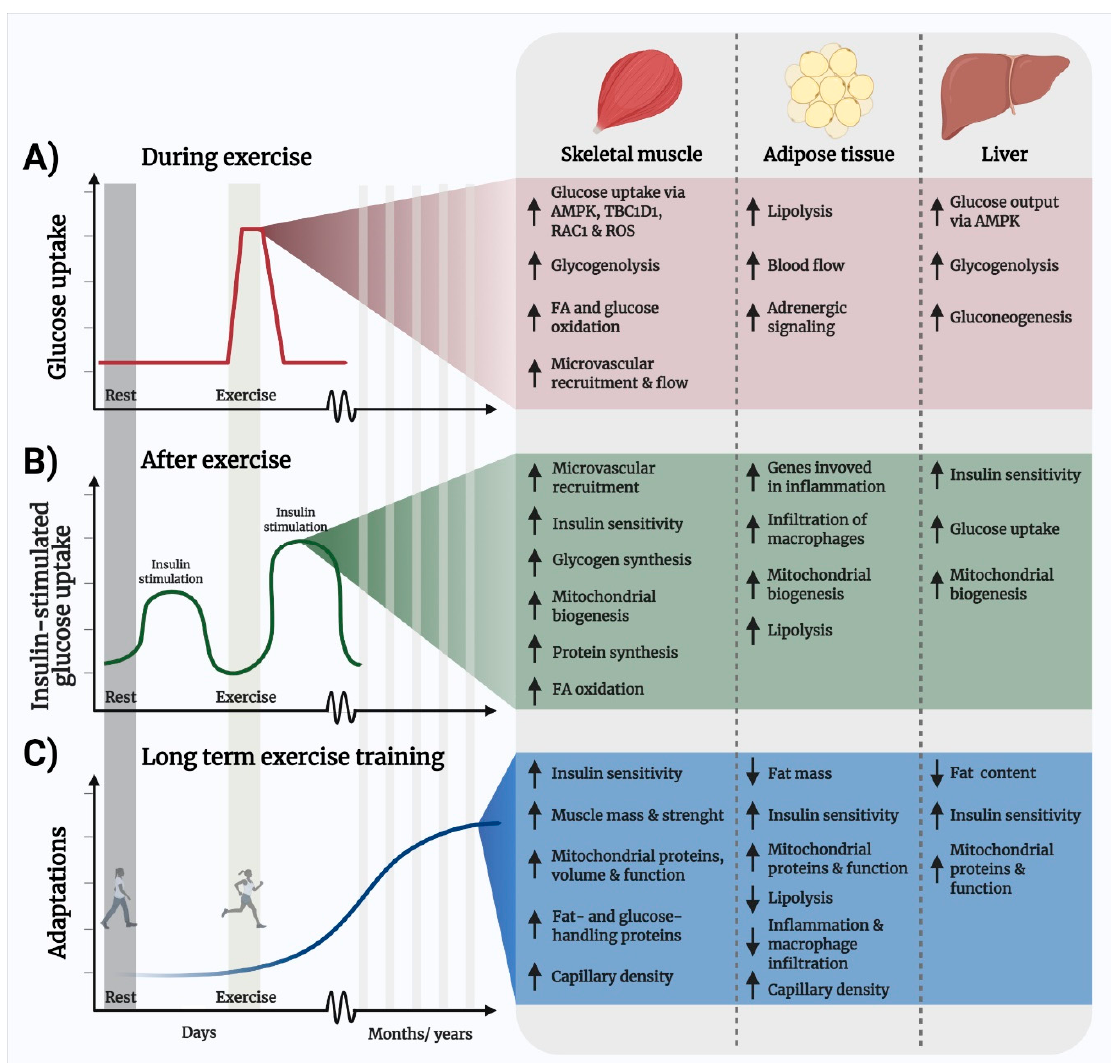
Figure 3. Illustration of the temporal metabolic benefits of exercise and molecular mechanisms . ( A ) One exercise bout elicits an acute and transient increase in muscle glucose uptake that is independent of insulin and persists in insulin-resistant subjects. ( B ) Insulin sensitivity (illustrated here as insulin-stimulated glucose uptake) is transiently enhanced for up to 48 h after the last exercise bout . ( C ) Repeated exercise training leads to longer-term adaptations, including increased expression of fat- and glucose-handling proteins and increased capillarization that improves insulin sensitivity and elevates muscle fat- and glucose-handling capacity. Abbreviations: AMP-activated protein kinase, FA; fatty acid, RAC1; Ras-related C3 botulinum toxin substrate 1, ROS, reactive oxygen species, TBC1D1; TBC1 Domain Family Member 1.